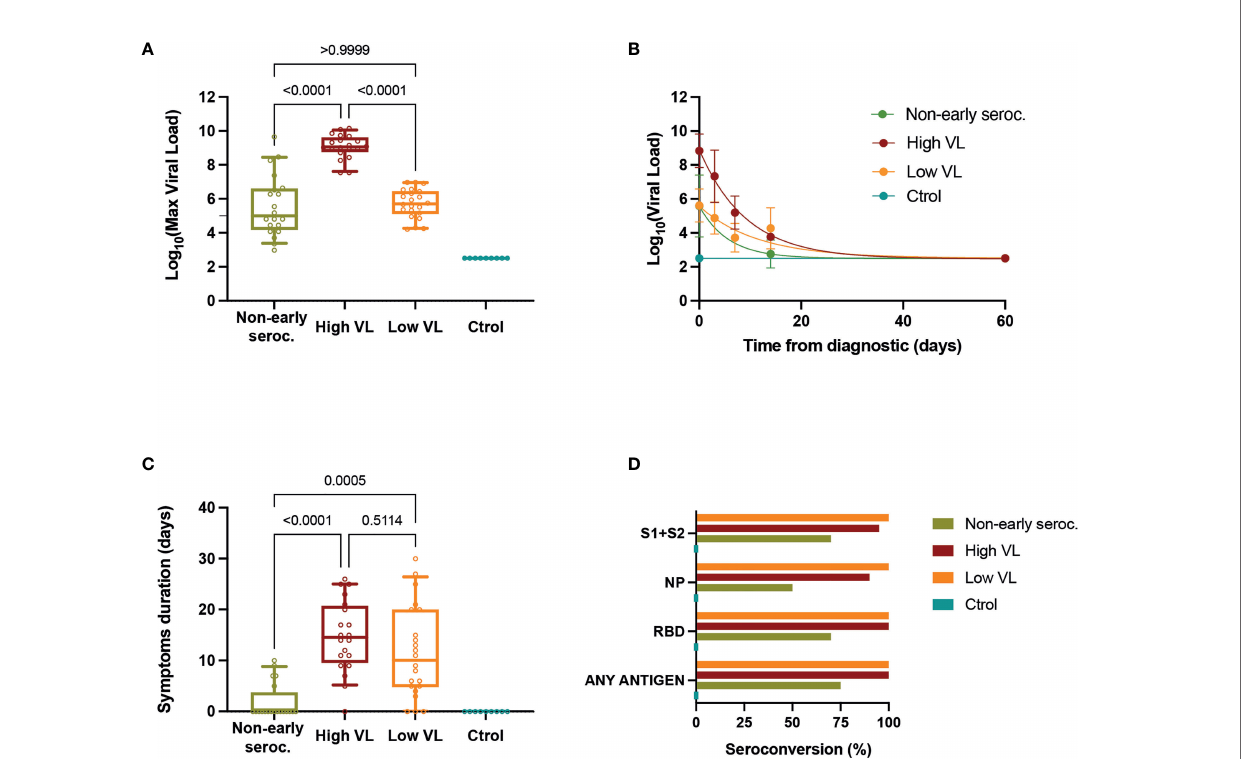
FIGURE 1 | Viral load determinations. (A) Maximal values of VL for each individual. Boxes show the median and the 25 th -75 th interquartile range and bars the 10 th - 90 th interquartile range. P values correspond to Kruskal-Wallis test with Dunn ’ s multiple comparisons. (B) VL dynamics in each group (mean ± SEM) with the best fi t curve (single exponential decay). (C) Self-reported symptom duration for each individual. Boxes show the median and the 25 th -75 th interquartile range and bars the 10 th -90 th interquartile range. P values correspond to Kruskal-Wallis test with Dunn ’ s multiple comparisons. (D) Seroconversion (frequency of positive samples for the indicated individual antigens or for any of them) in the different groups assessed by ELISA at day 60 of